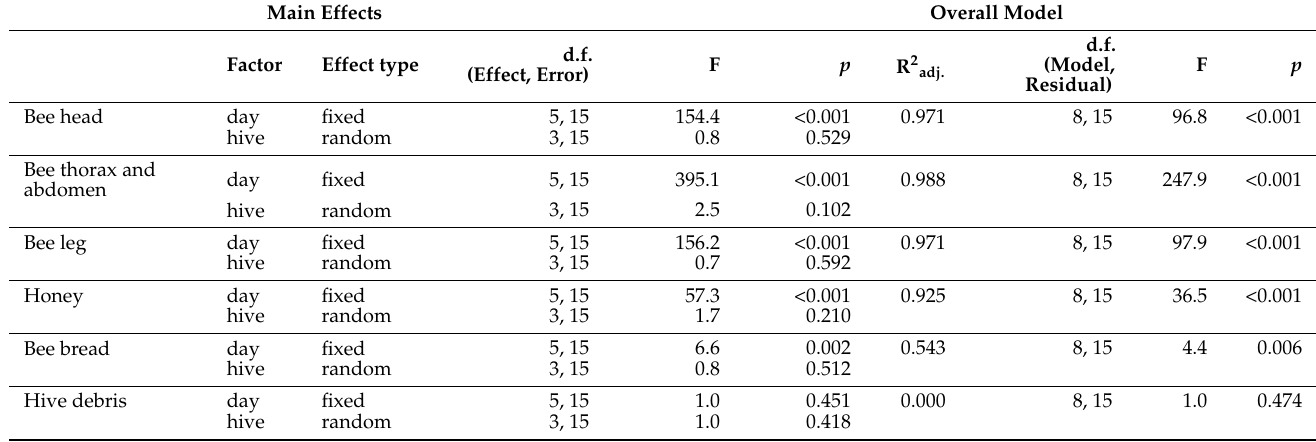
Table 2. Effect of lithium in bees and bee products in factor of time. Analysis of log-transformed Li concentration data using linear mixed models revealed a significant effect of time relative to the LiCl treatment (control: pre-treatment (day 0); treated: 1, 4, 8, 16, and 22 days post-treatment) of honeybee colonies on lithium concentration of the bees, the honey, and the bee bread, but not that of the wax and the hive debris. Results of Tukey HSD post hoc tests are shown in Figure